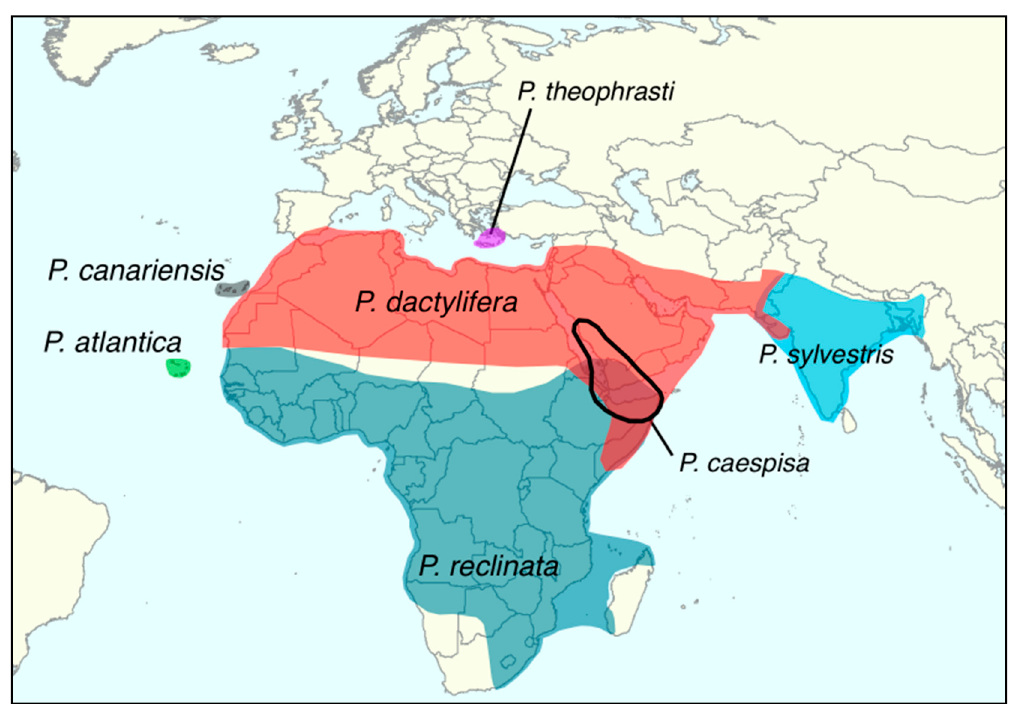
Figure 1. Distribution of the date palm and Phoenix species in Europe, Africa and Western Asia [5,6].